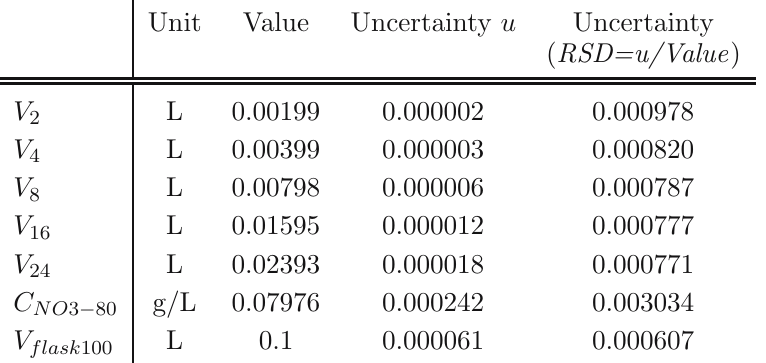
Table 3 Uncertainty components and their relative standard uncertainty of nitrate work- ing solution.